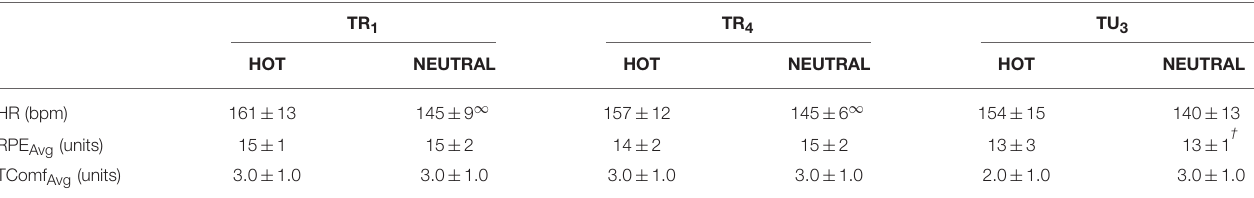
TABLE 2 | Physiological and perceptual observations during sub-maximal aerobic interval training from training sessions one, four, and the third top up